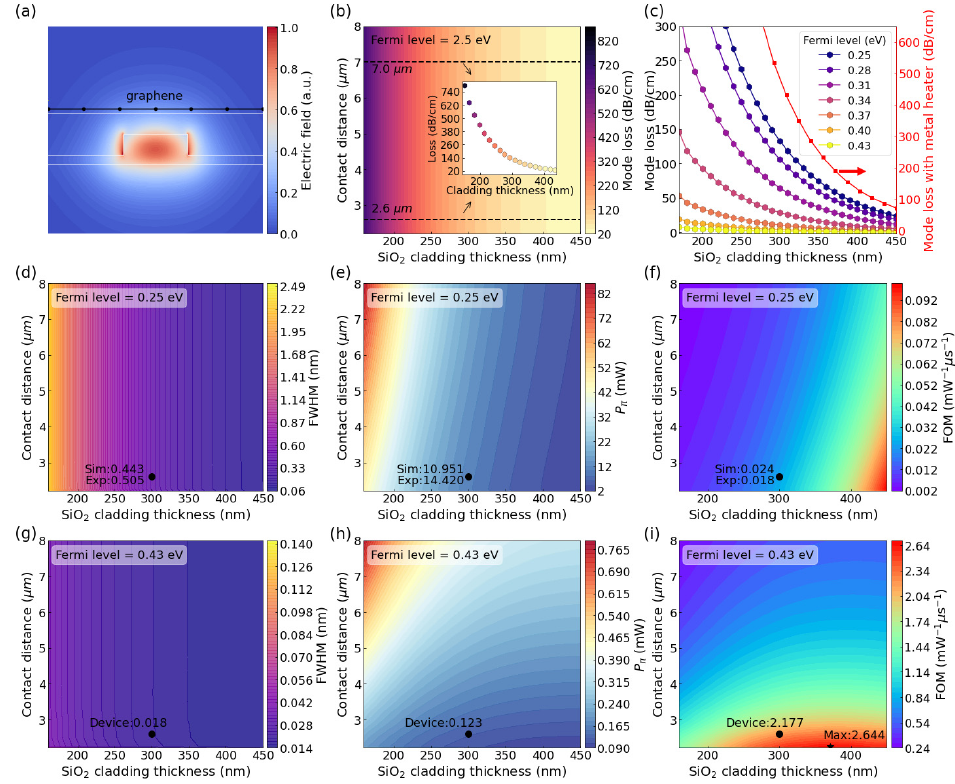
Figure 6. Simulation of the graphene-on-SOI structure. ( a ) Electric field distribution of the funda- mental TE mode. ( b ) Mode loss of the fundamental TE mode versus h cl and d c with E F of 0.25 eV. ( c ) Mode loss versus h cl with different E F and fixed contact distance of 2.6 μ m. The red curve denotes the mode loss of the waveguide with the metal heater. ( d ) FWHM , ( e ) power consumption P π and ( f ) FOM mapping for the MRR device with different h cl and d c , and Fermi level of 0.25 eV. ( g ) FWHM , ( h ) power consumption P π and ( i ) FOM mapping for the MRR device with different h cl and d c , and E F of 0.43 eV. Simulated (Sim) and experimental (Exp) values are labeled in ( d – f ). Simulated values of our devices (Device) are marked in ( g – i ). Star marker in ( i ) points out optimal structural parameters with maximum (Max) FOM